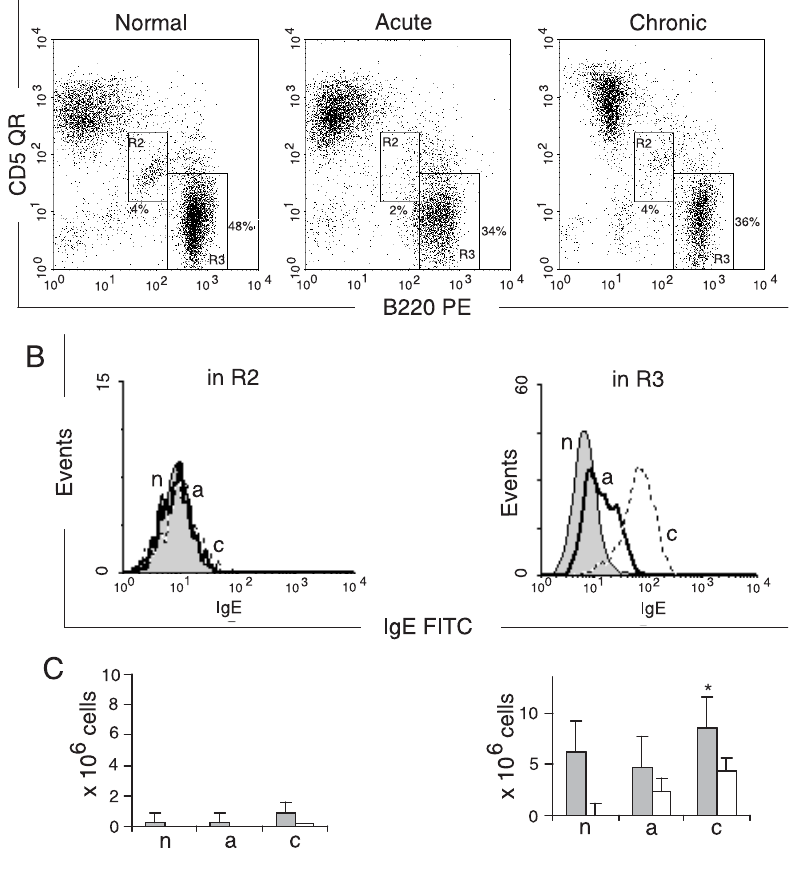
Figure 2 . Surface expression of B220, CD5 and IgE on cells from Peyer’s patches. A , Dot plot of cells in the lymphocyte gate. The R2 and R3 regions represent the B1 and B2 cells, respectively. B , Intensity of IgE on the B-cell sur- face. C , Total cell numbers (filled columns) and IgE+ cells (open columns). Data are reported as means ± SEM and are repre- sentative of five independent ex- periments, each carried out in 2 normal mice (n), 5 mice with acute infection (a) and 5 with chronic infection (c). *P < 0.05 for B-IgE + cells compared to to- tal B cells (Tukey multiple com- parison